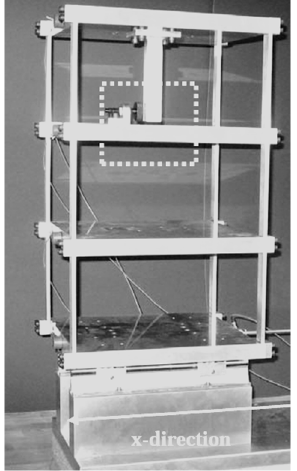
Figure 7. Qatar University grandstand simulator [146].